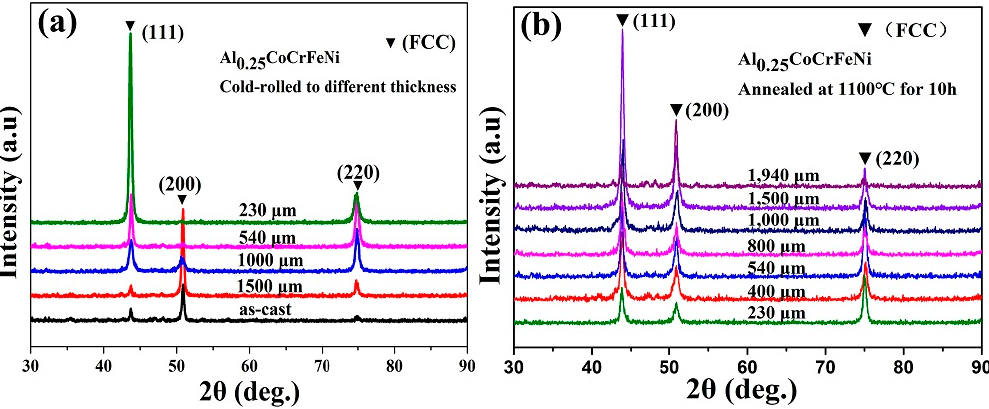
Figure 1. XRD patterns of HEA plates with various thickness: ( a ) after cold rolling; and ( b ) after annealing at 1100 °C for 10 h.